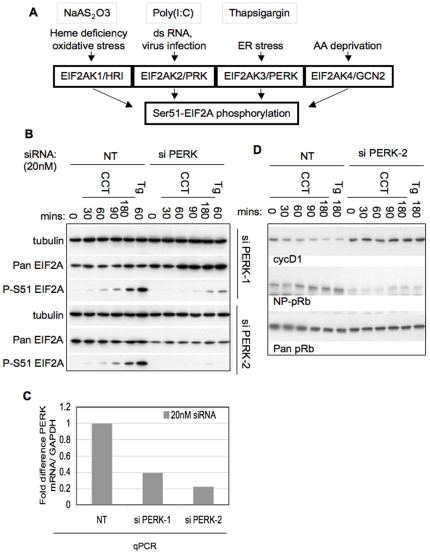
Signalling leading to CCT020312-dependent EIF2A phophorylation.
A) Schematic showing EIF2A kinases and their regulation. Pathway agonists thapsigargin, poly (I∶C) and NaAS2O3 and their locus of action are indicated. B) Effect of EIF2AK3/PERK ablation on EIF2A phosphorylation by CCT020312. U-2OS human osteosarcoma cells were transfected with either of two different EIF2AK3/PERK siRNA oligonucleotides (PERK-1, PERK-2) or an irrelevant control (NT) for 72 hours. Cells were treated with 10 µM CCT020312 (CCT) or 2 µM thapsigargin (Tg) for the indicated times. Lysates were analysed by immunoblot as indicated. C) Quantitation of PERK mRNA expression in siPERK transfected cells. PERK mRNA was quantified in siRNA tranfected cells using SYBR Green based quantitative PCR. The comparative cycle threshold method was used to determine the fold change in PERK mRNA relative to cells tranfected with irrelevant oligonucleotide. GAPDH was quantified in parallel and used to normalise between samples. Bars represent the mean fold change in triplicate technical replicates. D) Ablation of EIF2AK3/PERK prevents CCT020312-mediated cyclin D loss and accumulation of underphosphorylated pRB. HCT116 human colon cancer cells were transfected with EIF2AK3/PERK siRNA oligo ‘2’ or non-targeting siRNA (NT). After 72 hours cells were treated with 10 µM CCT020312, 2 µM thapsigargin (Tg) or DMSO for times indicated. Cell lysates were analysed by immunoblotting as indicated.